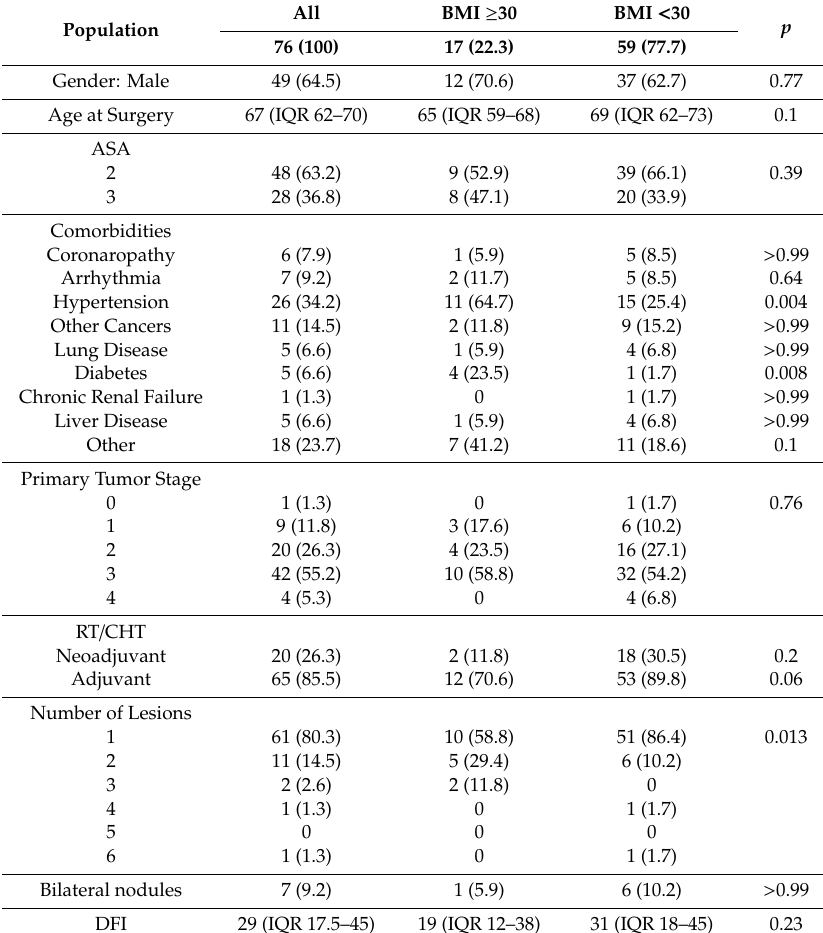
Table 1. Patients and tumor’s characteristics.